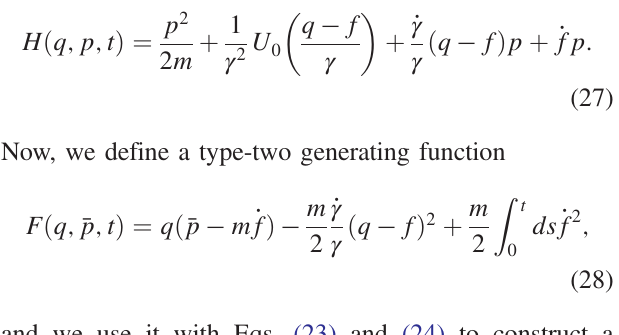
FIG. 1. Shortcut to adiabaticity based on dissipationless classical driving. Energy shells for a particle in a one-dimensional box [Eq. (42)], in a time-dependent piston of width L ð t Þ that changes at a constant rate u for t 0 ≤ t ≤ t 1 (inset). Energy shells corresponding to H 0 ð ¯ z ; L Þ are shown as a pair of parallel, dotted line segments of length L , at momenta (cid:2) ¯ p . The solid lines represent a level surface of the adiabatic invariant I corresponding to the full, counteradiabatic Hamiltonian H ð ¯ z ; L Þ (43). At t ¼ t 0 , the force f ð q; t Þ [Eq. (44)] induces a “ jump ” of trajectories ¯ z from dashed to solid lines — for t 0 ≤ t ≤ t 1 , the adiabatic energy shell is deformed invariantly — and finally, at t ¼ t 1 , force f ð q; t Þ [Eq. (44)] induces jumps back to ¯ p